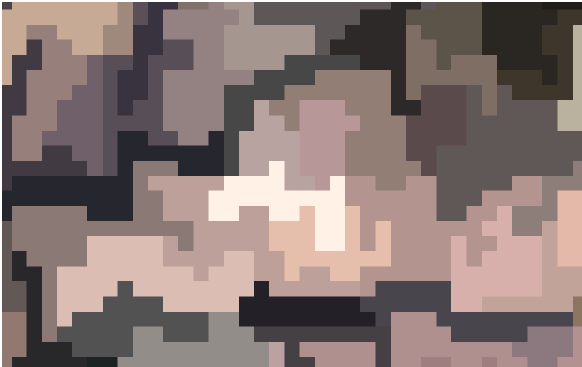
Figure 6. Subset of Landsat-8 segmented